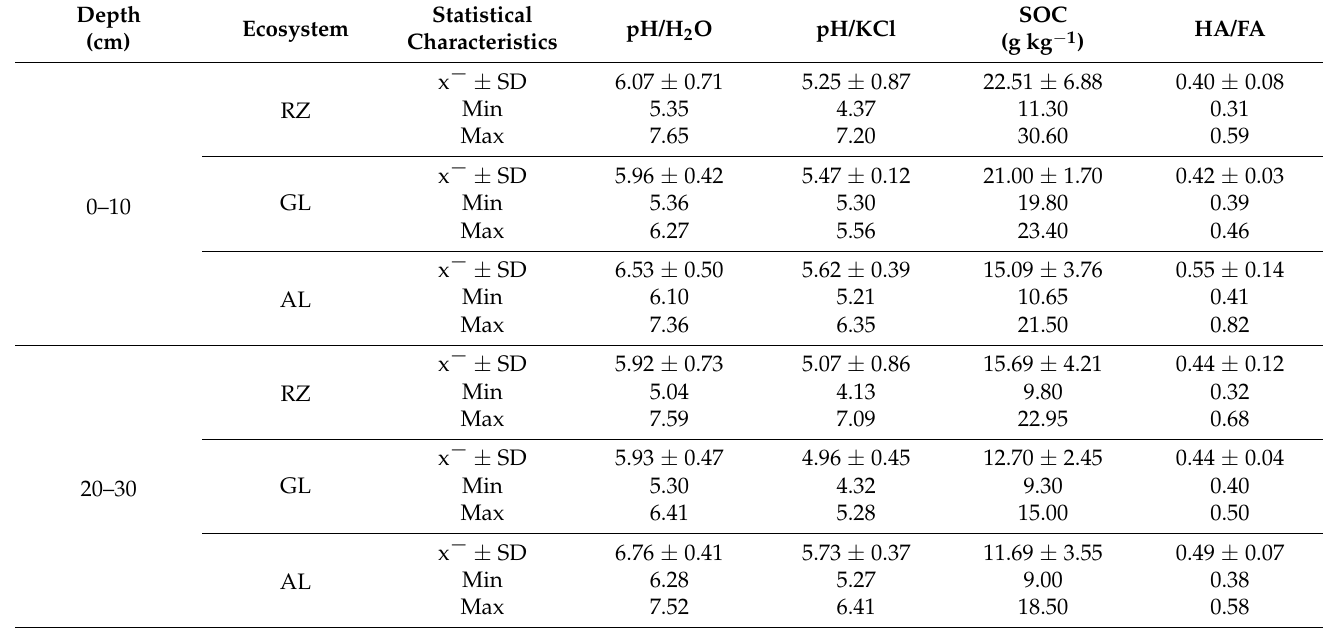
Table 1. Soil chemical